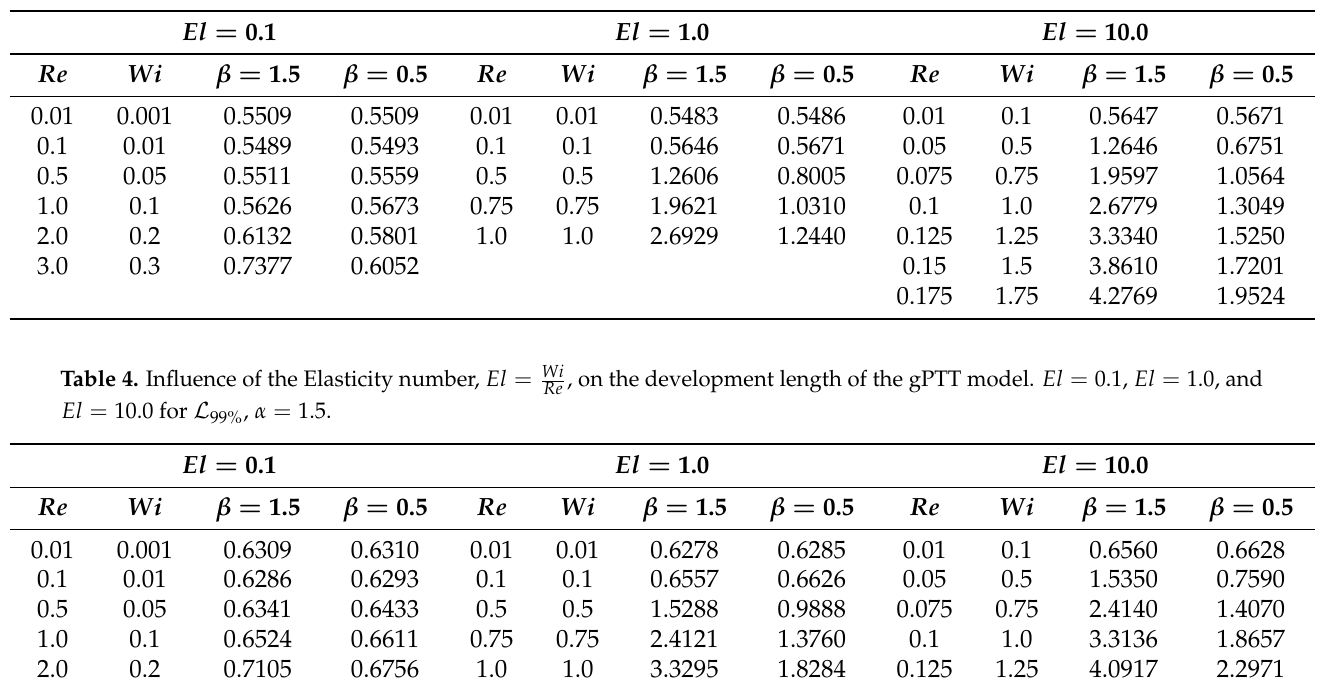
, on the development length of the gPTT model. El = 0.1, El = 1.0, and Re